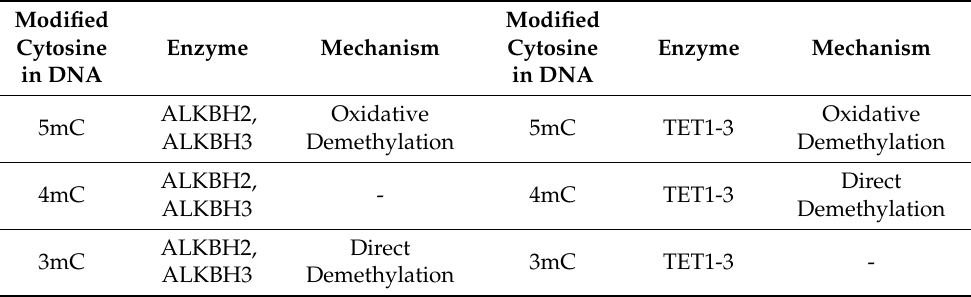
Table 1. The table lists modified cytosines in DNA, Fe(II)/2OG-dependent dioxygenases and their mechanism of action, which demonstrates the functional flexibility of ALKBH2,3 and TET family dioxygenases.